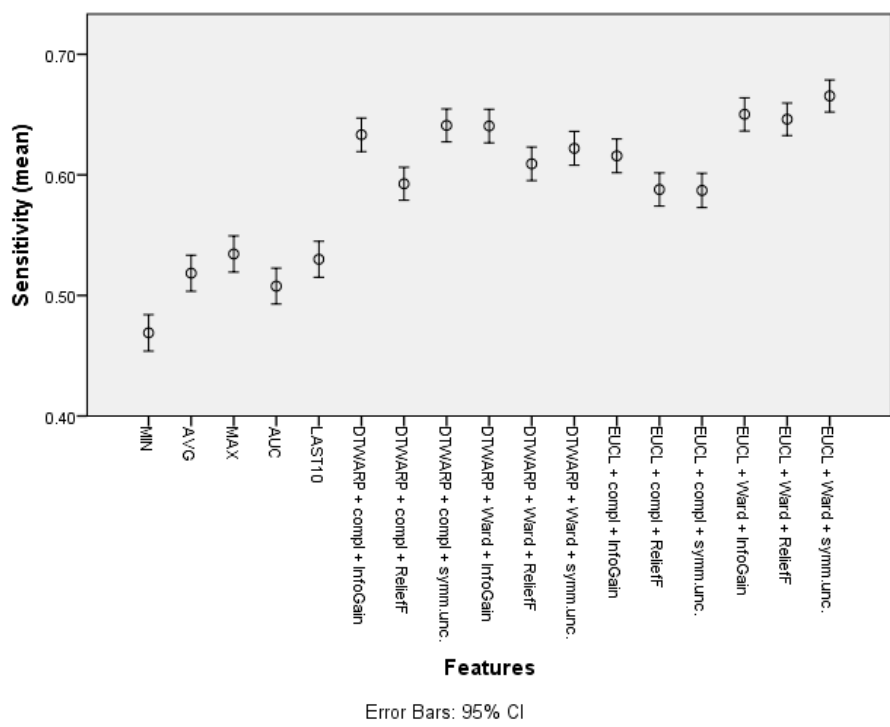
Figure 7. Specificity of Naïve Bayes classifiers: mean values and 95% confidence intervals. The mean area under the ROC curve (presented in Figure 8 with 95% confidence in- tervals as error bars) was lower in the datasets in which the common features were used;